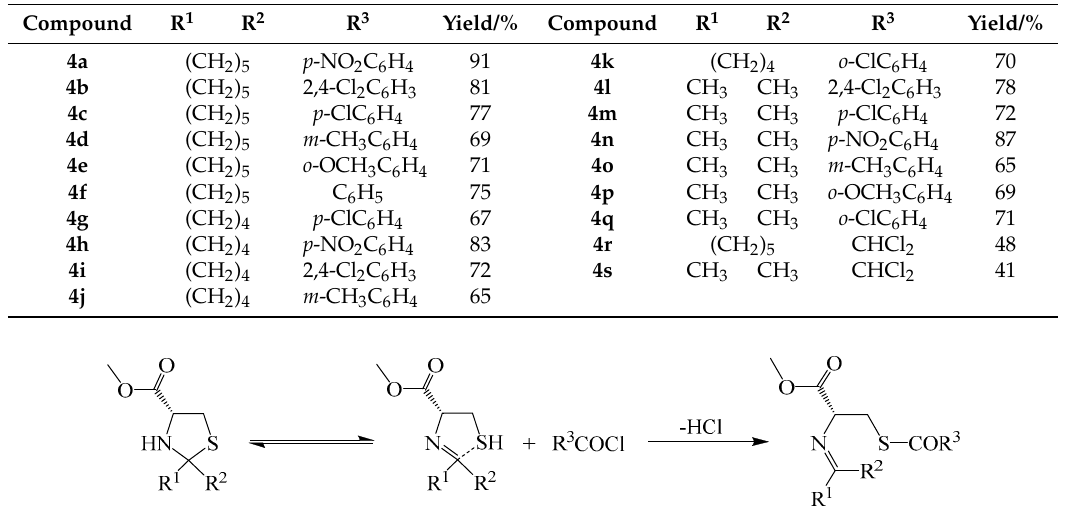
Scheme 4. Mechanistic outline for the ring-opening reaction.